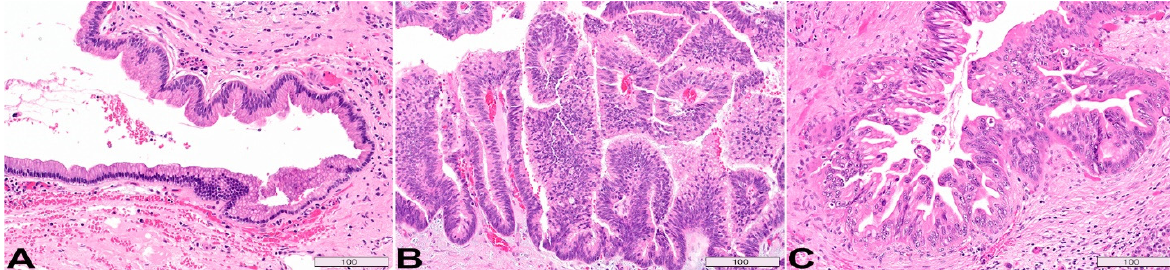
Figure 3. Histologic subtypes of IPMN. ( A ) Gastric type resembles gastric foveolar epithelium, composed of tall columnar cells with basally oriented small nuclei and abundant cytoplasmic mucin, typically low-grade dysplasia, commonly seen in branch ducts. ( B ) Intestinal type features hyperchromatic villous papillae with elongated and crowded nuclei, basophilic cytoplasm, often high-grade dysplasia, associated with main duct. ( C ) Pancreaticobiliary type is characterized by amphophilic to eosinophilic cytoplasm, enlarged nuclei with prominent nucleoli, and moderate cytoplasmic mucin. It often shows high-grade dysplasia and typically involves the main duct. All H&E stain, original magnification, 200x. Scale bars, in µm.